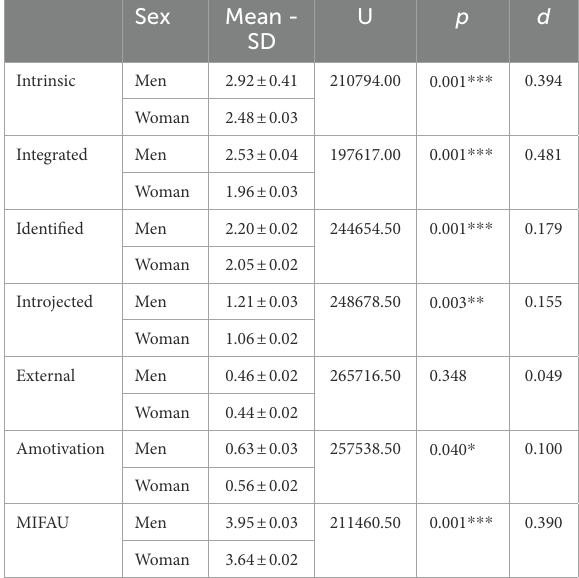
TABLE 3 Inferential results of the regulation of motivation and intention to be physically active as a function of gender. Sex